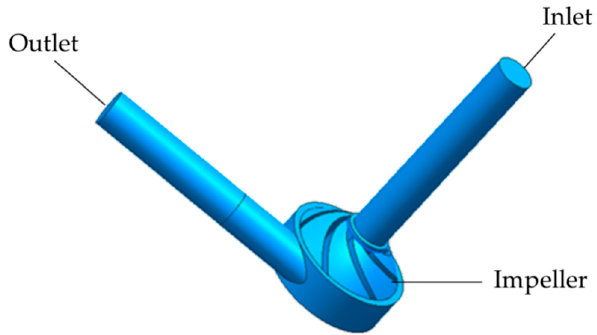
Figure 2. 3D modeling of the calculation area of the centrifugal blood pump.